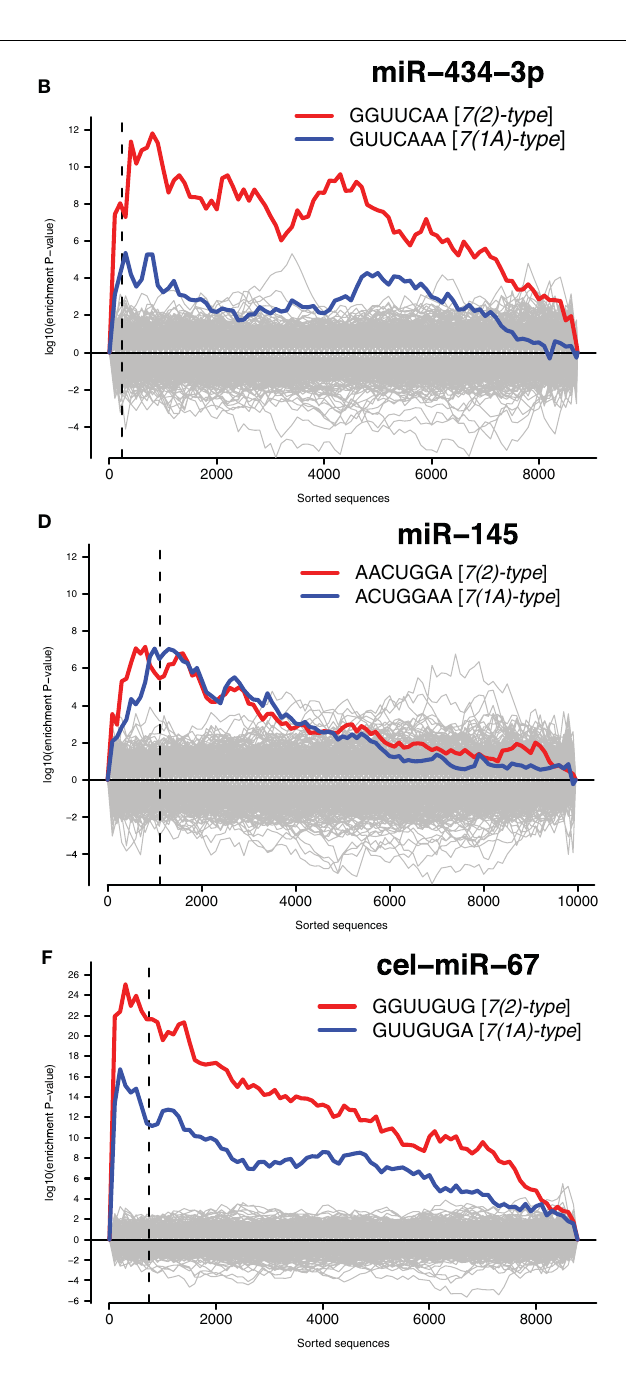
FIGURE 3 | Identified putative direct miRNA targets. The x -axes represent 3 (cid:48) UTRs corresponding to genes sorted from most downregulated to most upregulated in comparison to cultures transfected with (A) miR-124 mimic and inhibitor, (B) miR-434-3p mimic and inhibitor, (C) miR-143 mimic and inhibitor, (D) miR-145 mimic and inhibitor, (E) miR-25 mimic and inhibitor, (F) ce-miR-67 mimic and mock transfected